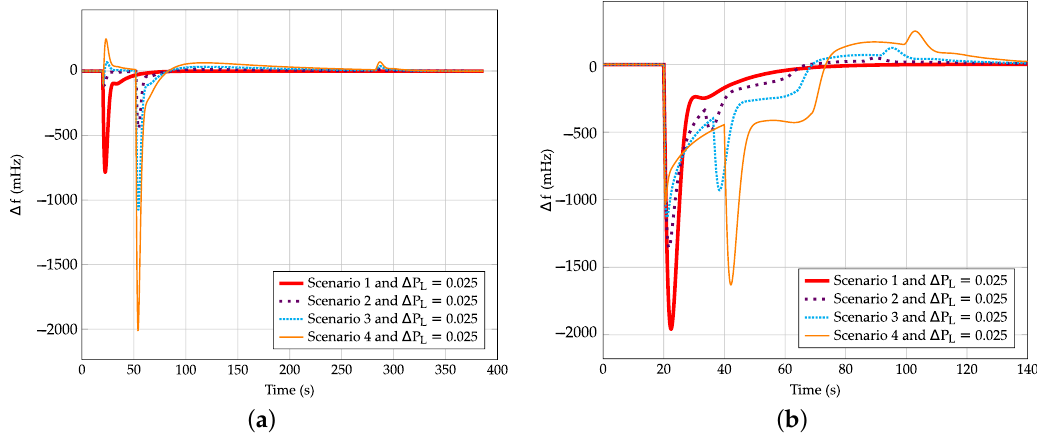
Figure 15. Comparison between frequency excursion for scenarios 1–4 including wind power plant controls and considering ∆ P L = 0.025. ( a ) Controller from [23]; ( b ) Proposed control with x = 0.75.